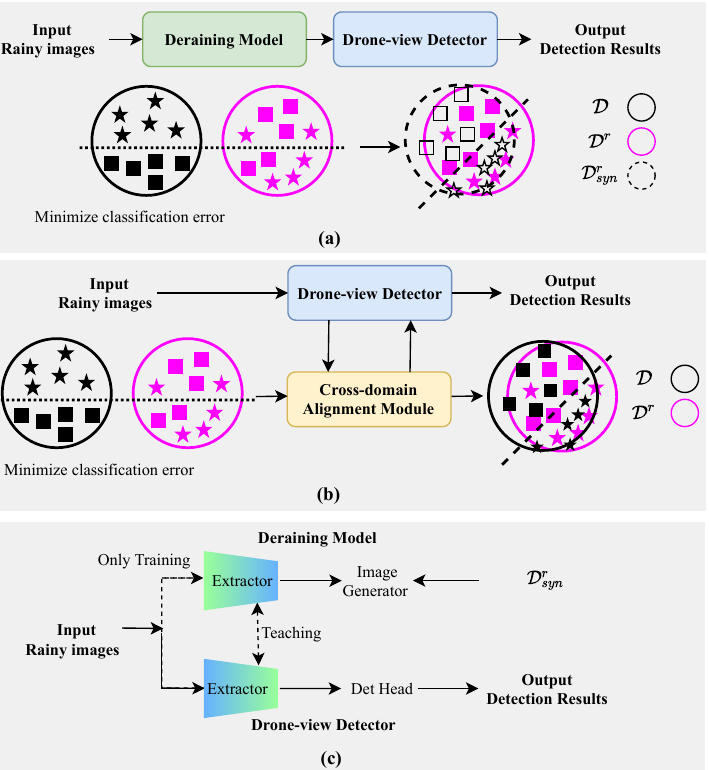
Figure 1. Comparison of the proposed CoDerainNet and existing detectors for Rainy DroneDet. ( a ) ImDrain-based methods, ( b ) DA-based methods, ( c ) our